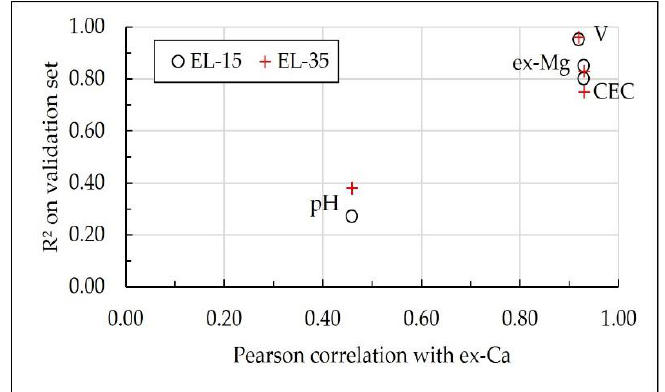
Figure 5. Scatter plot of the determination coe ffi cient (R 2 ) obtained on the validation set of models calibrated for cation exchange capacity (CEC), pH, base saturation (V), and exchangeable (ex-) Mg versus the correlation coe ffi cient (r) of each mentioned attribute with the ex-Ca content. The relationships for the XRF data scenarios EL-15 and EL-35 are represented by circles and crosses,